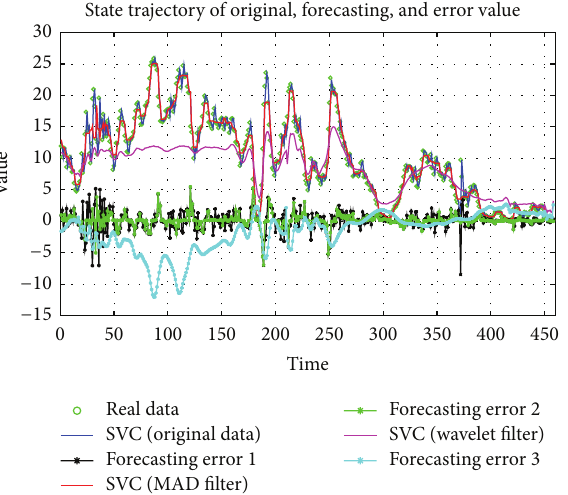
Figure 8: Final forecasting results via